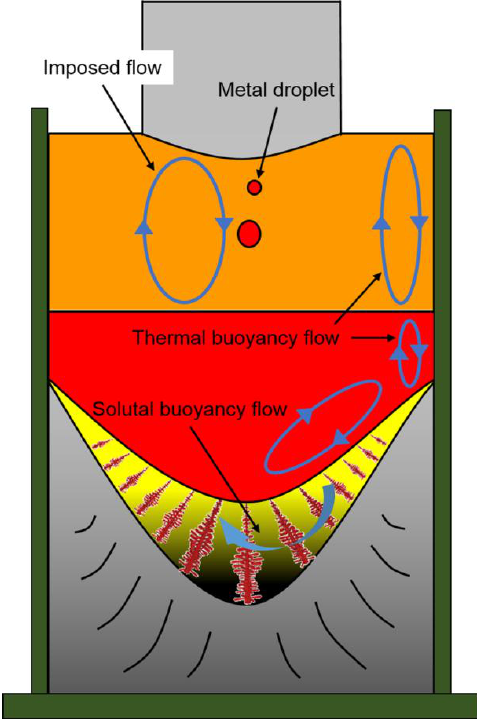
Figure 5. Schematic of the flows of the molten slag and metal pools in the ESR process.